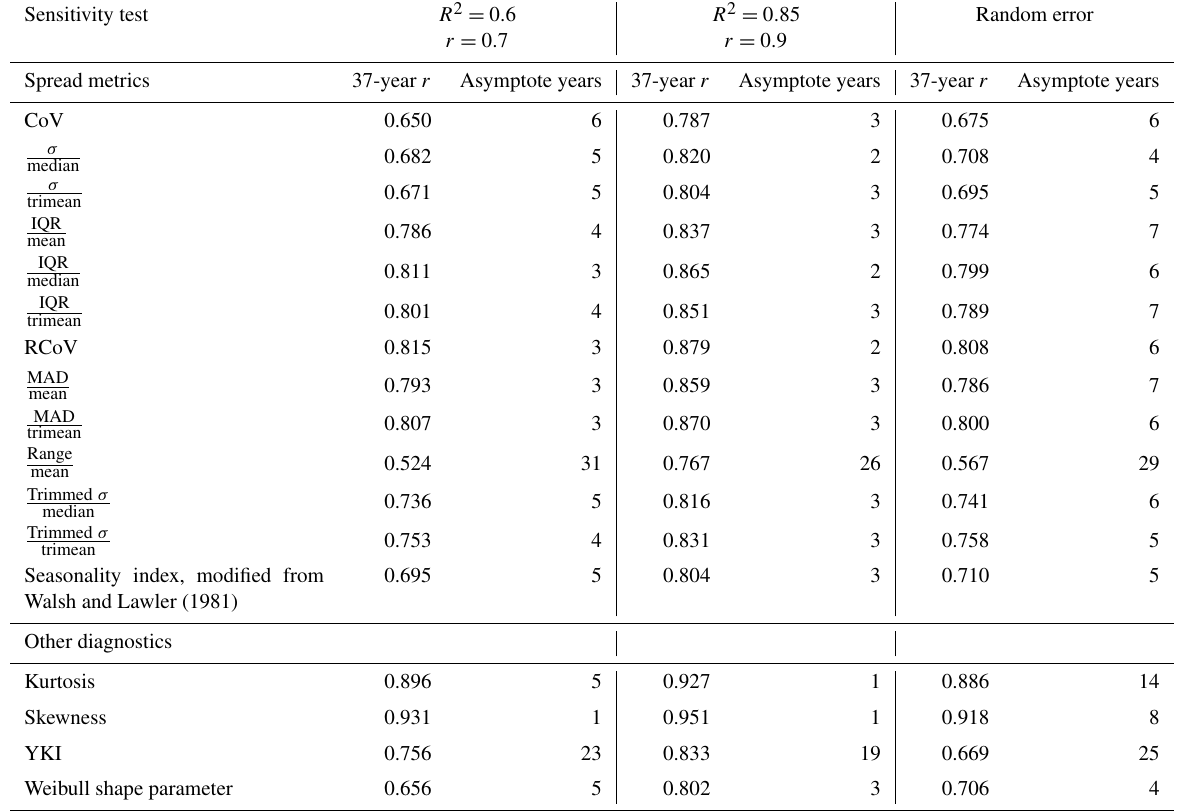
Table B3. As in Table 3, but with the calculated metrics, the associated correlations, and asymptote periods using different R 2 and r filters and adding the randomized standard error to predicted monthly total energy production. The sample sizes of the 0.7- r threshold test, the 0.9- r threshold test, and the random error test are 306, 83, and 195 wind farms,